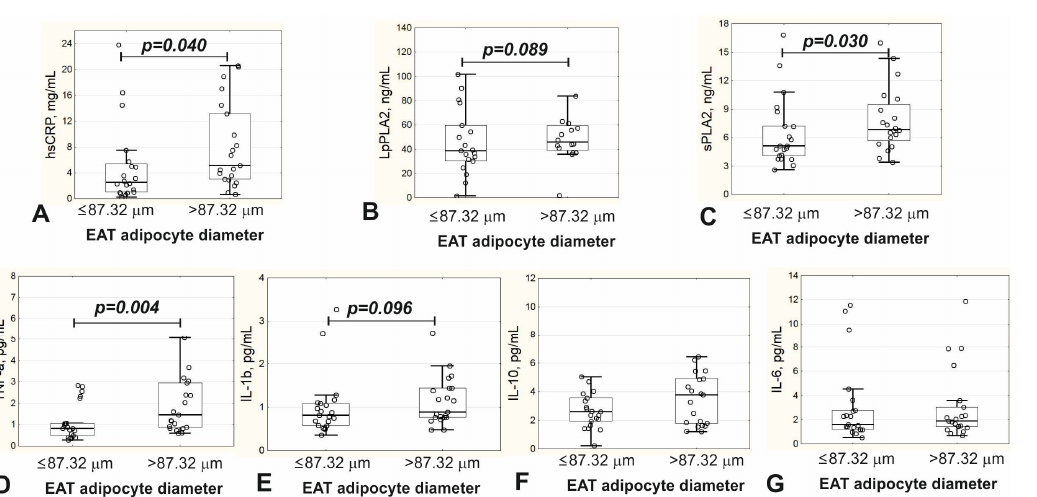
Figure 2. Serum concentrations of inflammatory biomarkers in patients with EAT adipocyte diam ‐ eter ≤ 87.32 μ m and >87,32 μ m. ( a ) Concentration of hsCRP; ( b ) concentration of LpPLA2; ( c ) con ‐ centration of sPLA2; ( d ) concentration of TNF ‐α ; ( e ) concentration of IL ‐ 1 β ; ( f ) concentration of IL ‐ 10; ( g ) concentration of IL ‐ 6; EAT, epicardial adipose tissue; hsCRP, high ‐ sensitive C ‐ reactive pro ‐ tein; LpPLA2, lipoprotein ‐ associated phospholipase A2; sPLA2, secreted PLA2; TNF ‐α , tumor ne ‐ crosis factor alpha; IL, interleukin; p , the level of statistical significance of the differences between patients with EAT adipocyte diameter ≤ 87.32 μ m and patients with EAT adipocyte diameter > 87.32 μ m.